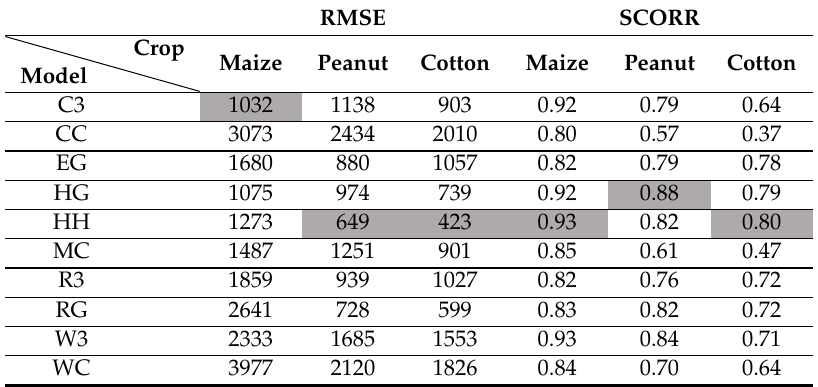
Table 2. Spatial RMSE and SCORR (spatial correlation) for 30-yr average (1971–2000) crop yield under rainfed conditions. Gray cells denote the best statistics among the analyzed group.